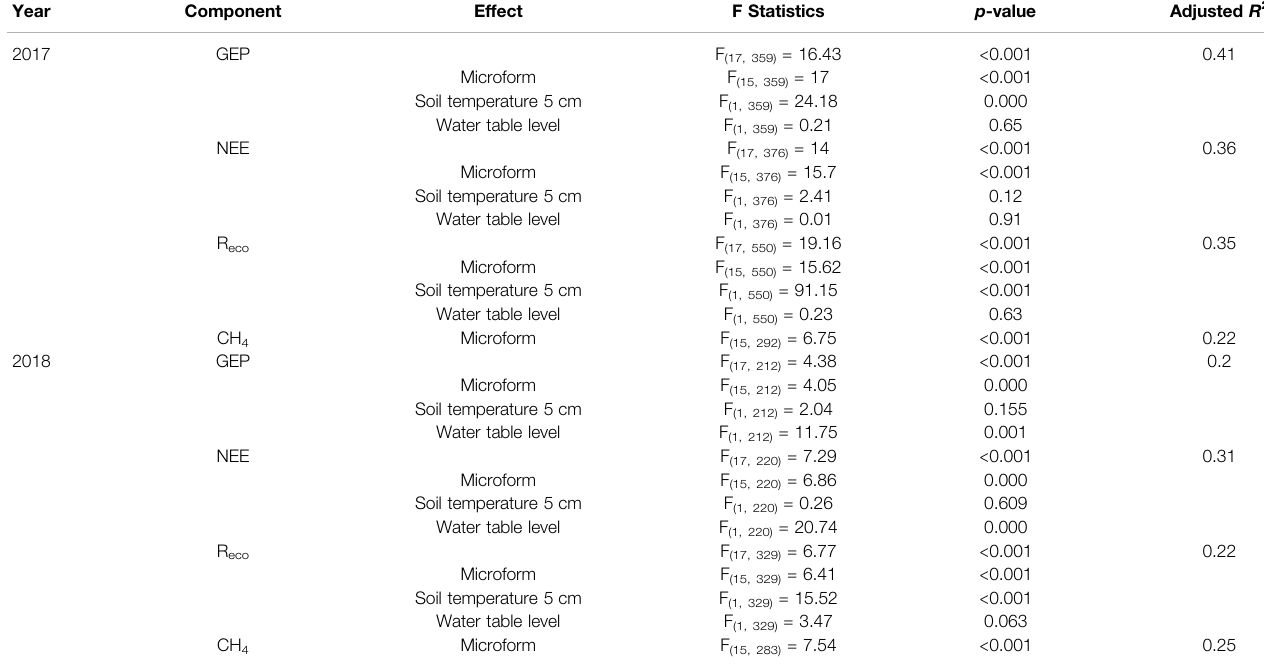
TABLE 5 | Statistical results of ANOVAs for fl uxes in 2017 and